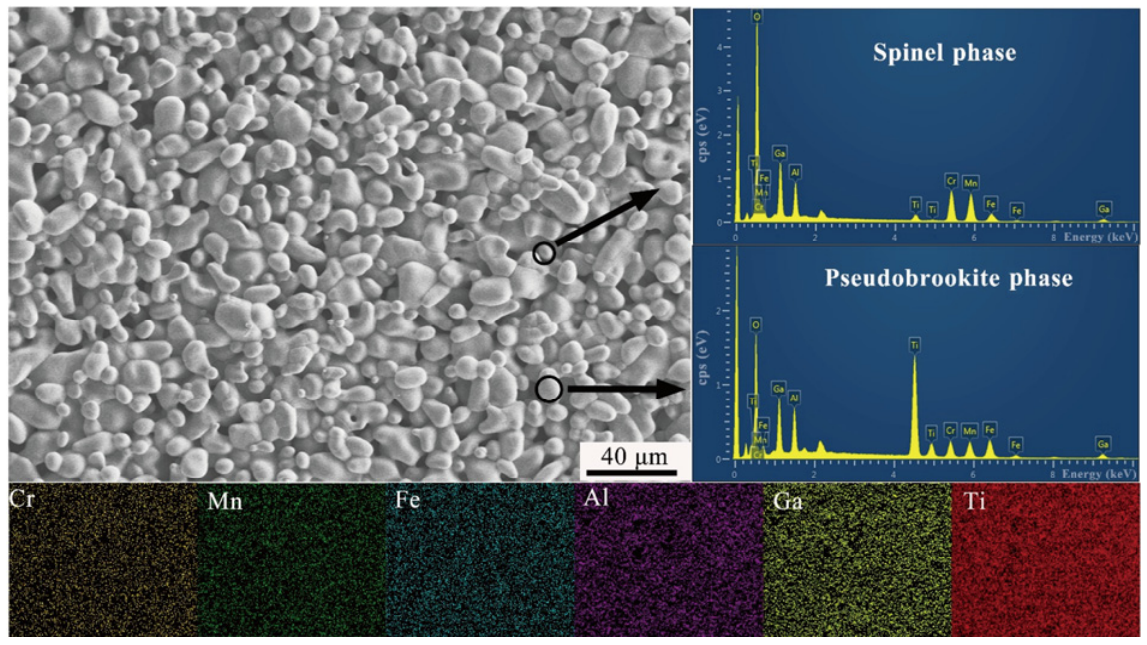
Fig. 6 Surface morphology image and corresponding EDS mappings of B2T after sintering at 1400 ℃ . Table 2 Quantitative analysis of B2T after sintering at 1400 ℃ (relative ratios of the molar content of each element) Cr Mn